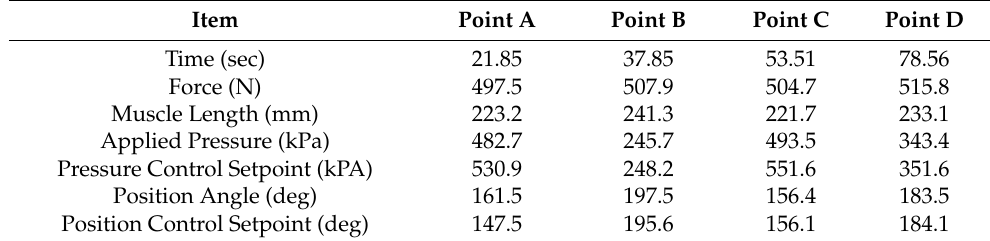
Table 7. Numerical values for critical points in Figure